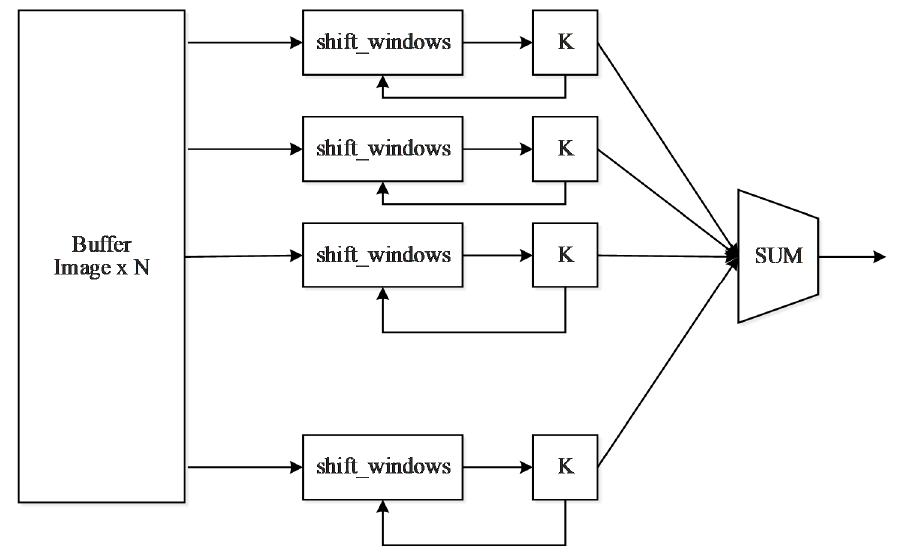
Figure 4. The structure of the convolutional unit.